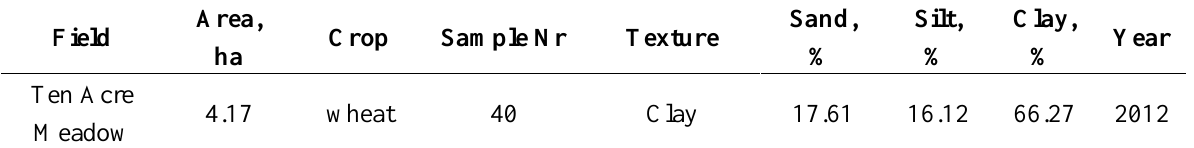
Table 1. Information about the Ten Acre Meadow field in Duck End Farm, Bedfordshire,